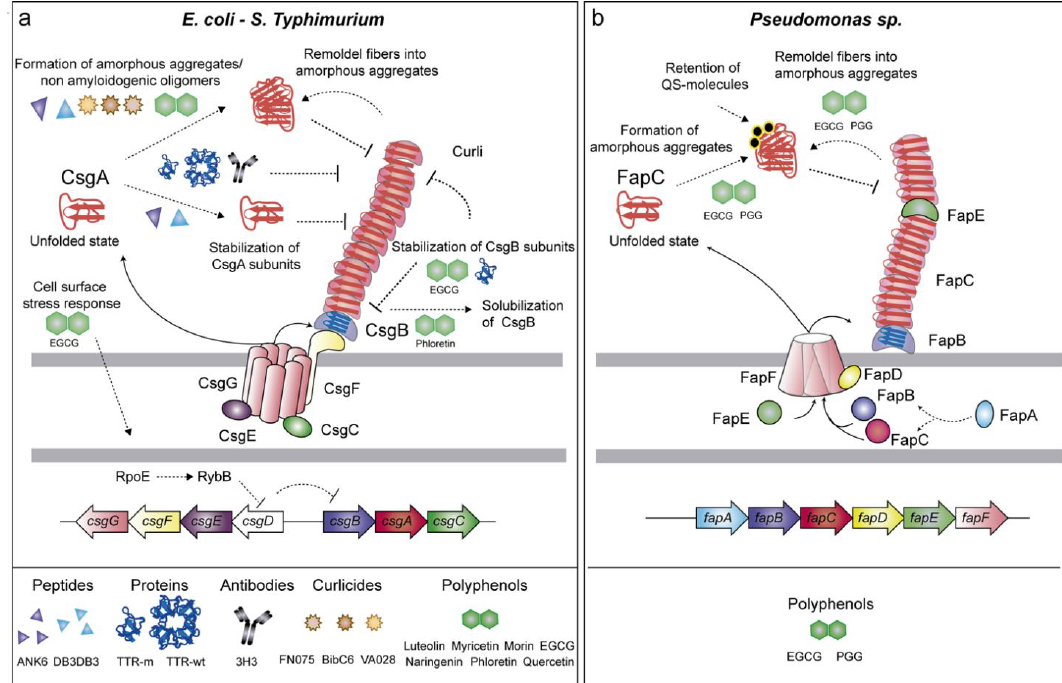
Figure 1. Schematic representation of the genes involved in the formation of intrinsic amyloids, the drugs targeting such structures and their mechanism of action. ( a ) The formation of E. coli and S. Typhimurium curli amyloids is affected by several drugs, which act by different mechanisms: (i) stabilization of CsgA monomeric subunits; (ii) formation of amorphous or non-amyloidogenic aggregates; (iii) disaggregation of already-formed fibers; (iv) prevention of CsgB polymerization; (v) solubilization of CsgB; (vi) activation of the cell surface stress response, which reduces the expression of the curli regulator CsgD. ( b ) Pseudomonas Fap amyloids are inhibited by EGCG and PGG polyphenols, which lead FapC to off-pathway oligomers, remodeling fibers into amorphous aggregates and retaining quorum-sensing molecules. Table 1. Classification of functional amyloids.